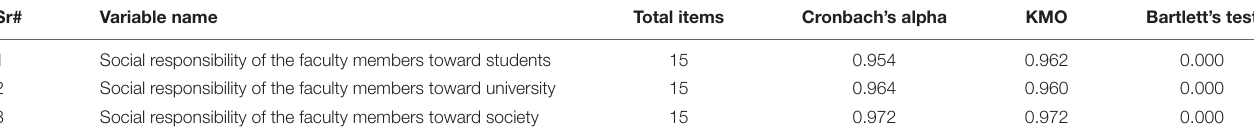
TABLE 1 | Reliability and validity of